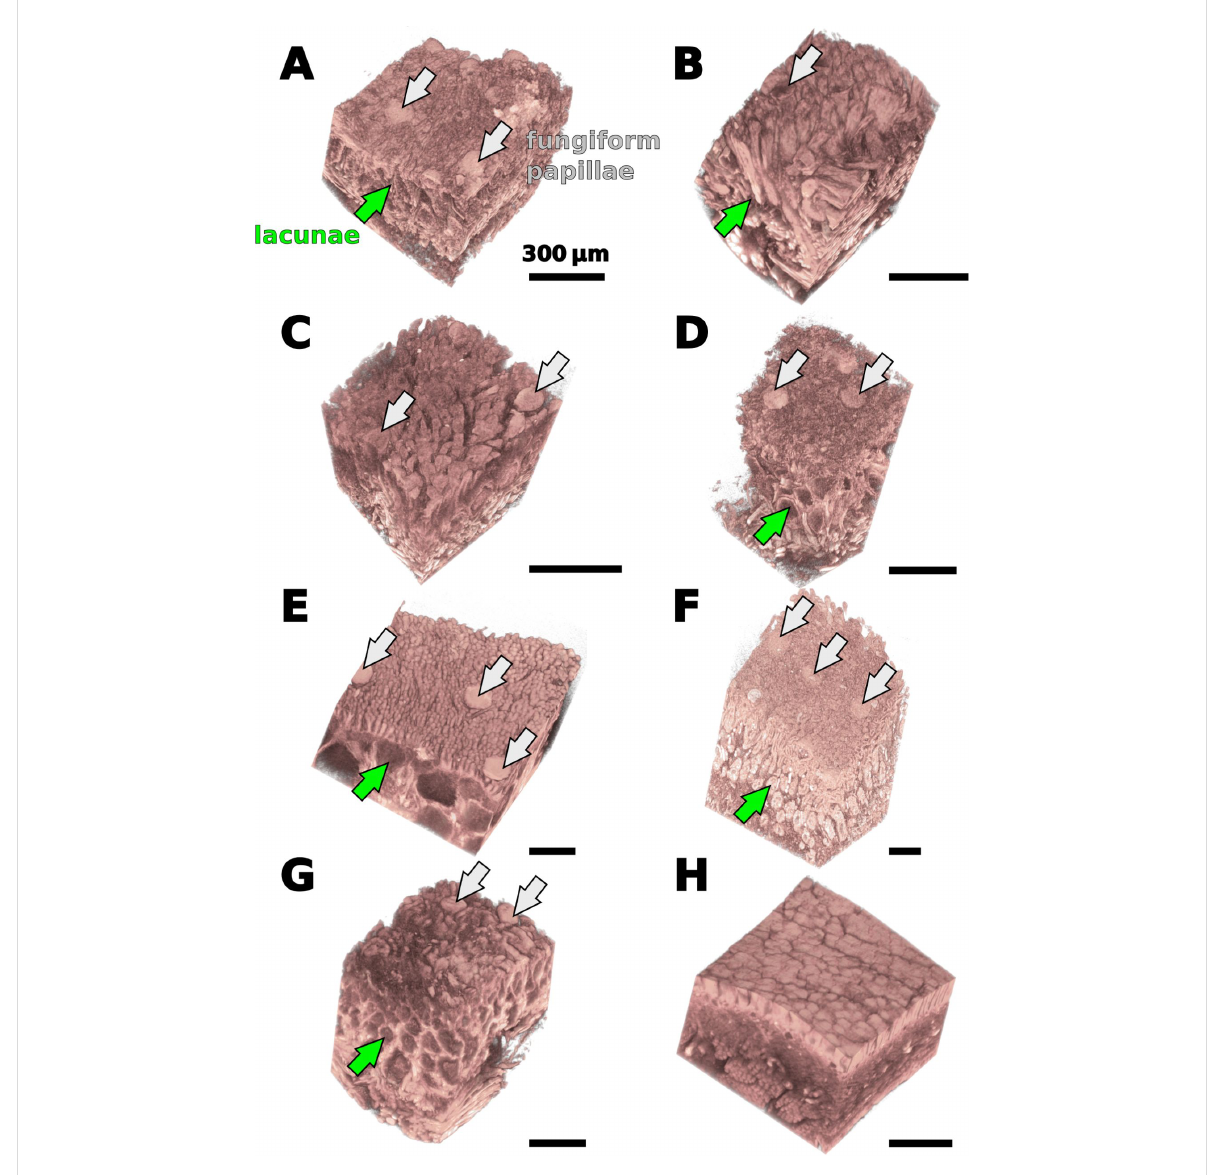
Figure 3: Micro-CT images of tissue fragments that were derived from the surfaces of frog tongues. A – Bombina variegata , B – Discoglossus pictus , C – Ceratophrys ornata , D – Litoria caerulea , E – Megophrys nasuta , F – Rana ( Lithobates ) pipiens , G – Bufo bufo , H – Oophaga histrionica . Except for C. ornata (C) and O. histrionica (H), the fungiform papillae (grey arrows) can easily be identified in the micro-CT data. Underneath the papillary surface structures lies a layer with lacunar structures that appear hollow in the micro-CT scan (green arrows). Both size and shape of these lacunae strongly vary among different